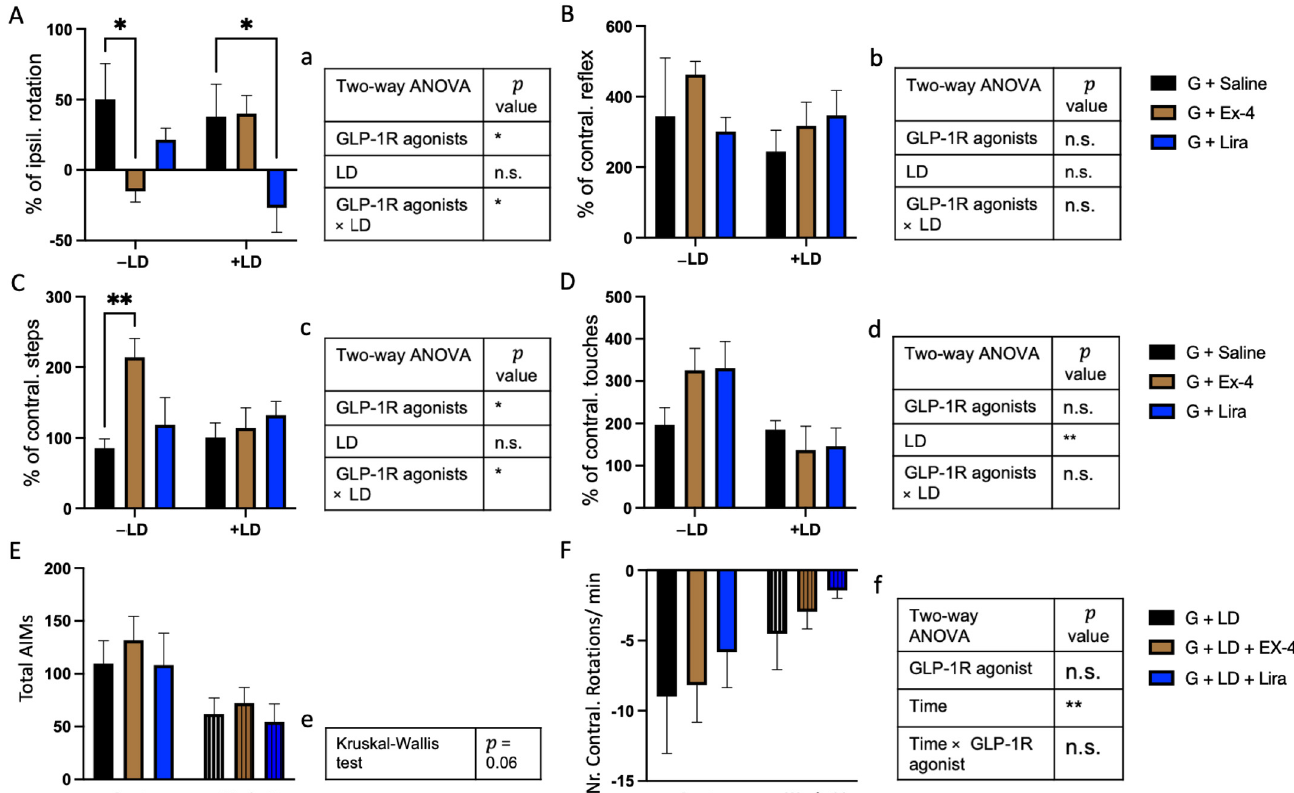
Figure 3. The effect of GLP-1R agonists and L-dopa on the motor and L-dopa induced dyskinesia tests. ( A ) Amphetamine induced rotation test, ( B ) vibrasae test, ( C ) stepping test and ( D ) cylinder test on week 12 post transplantion of rats received either saline, Ex-4 or Lira in − /+ LD groups. The data were expressed as a percentage of the baseline (pre-transplantation time point) in number of ipsilateral rotations, contralateral reflex, contralateral steps and contralateral touches, respectively. ( E ) AIMs ( F ) L-dopa induced rotation received either Ex-4, Lira or no GLP-1R agonists in +LD treated groups at pre-trx and week 11 time points. The data were expressed as total number of AIMs or number of contralateral rotations per min, respectively. ( a – f ) illustration of statistical summary of ( A – F ) respectively. ( A – D , F ) two-way ANOVA, ( E ) Kruskal-Wallis test, * p < 0.05, ** p < 0.01. n = G − LD (7), G + LD (8), G − LD + Ex-4 (9), G + LD + Ex-4 (8), G − LD + Lira (6), G + LD + Lira